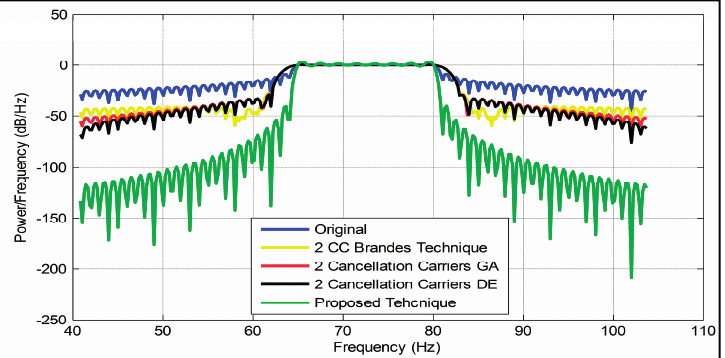
Figure 4. The PSD comparison between the proposed technique and existing techniques including SW, CC (Brandes), CC (GA), and CC